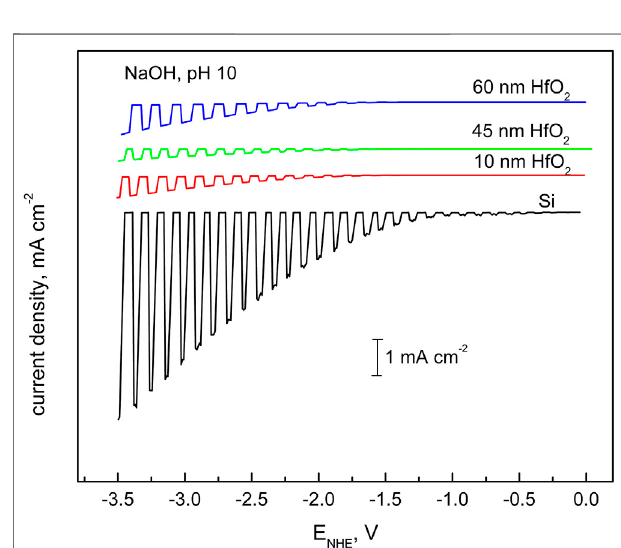
FIGURE 7 | Cathodic photocurrents of hydrogen reduction over wide region of cathodic voltages obtained for p -Si – H electrode prepared by treatment in HF solution (marked as Si) and that coated with the HfO 2 layer with different thicknesses. Electrolyte: NaOH solution at pH 12. The illumination of 505-nm wavelengths and intensity of 50 mW cm − 2 have been chopped at certain intervals. The potential sweep rate was 5 mV s − 1